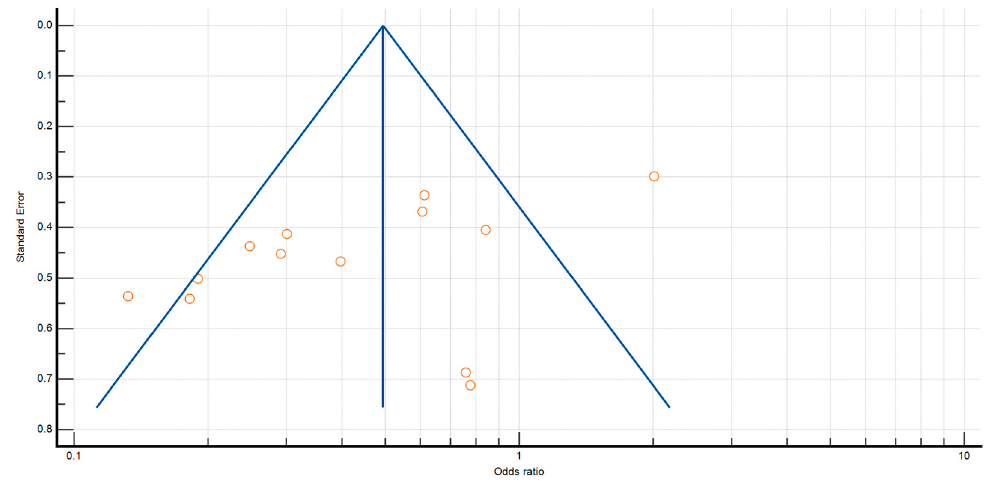
Figure 3. Funnel plot for surgical site infections.